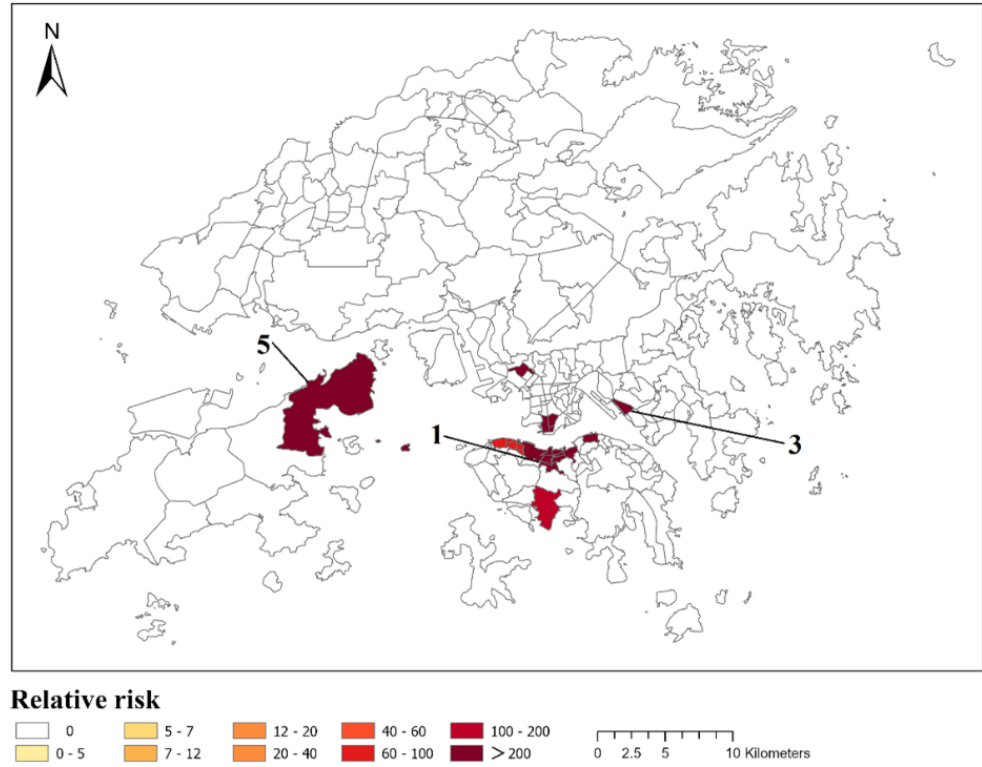
Figure 8. Space–time cluster distribution in stage I at non-residential locations (In which number 1, 3, 5 indicate the most significant clusters) .